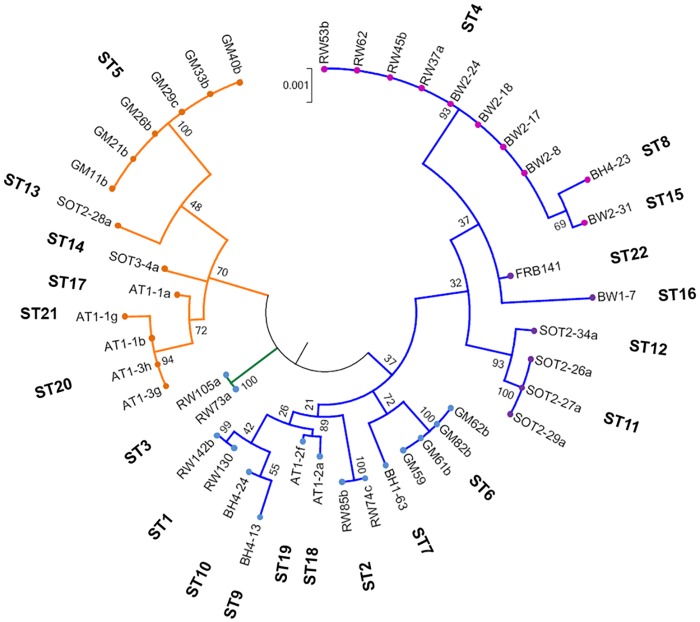
Phylogenetic tree of 44 B. goodwinii strains based on a concatenated sequence of 7 housekeeping gene fragments (abc, dnaJ, dnaN, gyrB, infB, nusA, rpoB).The evolutionary history was inferred by using the Maximum Likelihood method based on the Hasegawa-Kishino-Yano model (HKY+G+I) with estimated transition/transversion bias value. The tree with the highest log likelihood (-13387.9427) is shown. Initial tree for the heuristic search was obtained automatically by applying Neighbor-Join and BioNJ algorithms to a matrix of pairwise distances estimated using the Maximum Composite Likelihood approach, and then selecting the topology with superior log likelihood value. The tree is drawn to scale, with branch lengths measured in the number of substitutions per site. The numbers at the nodes represent the relative distance between the strains with bootstrap support from 1000 resampled datasets. Individual Sequence Type (ST) numbers are indicated. Different colour nodes show the four corresponding clusters estimated by the Discriminant Analysis of Principal Components (Fig 4). Blue and orange colour branches indicate a separation into 2 clusters of STs within the population, whereas green colour branch indicate the recombinant genotype as estimated by STRUCTURE analysis (Fig 5). Gibbsiella quercinecans type strain FRB97 (Brady et al., 2010) was used as the outgroup (S1 Fig).